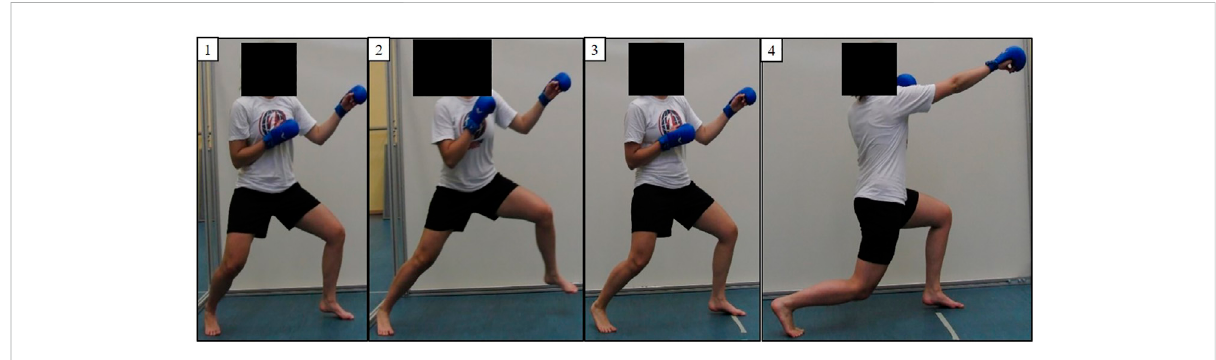
FIGURE 1 Series of pictures demonstrating the karate attack Gyaku-Zuki jodan (GZj). (1) starting position (kamae), (2) distance reduction towards the opponent, (3) pulling up the back leg, (4) pushing off the rear fi st to the head of the opponent.